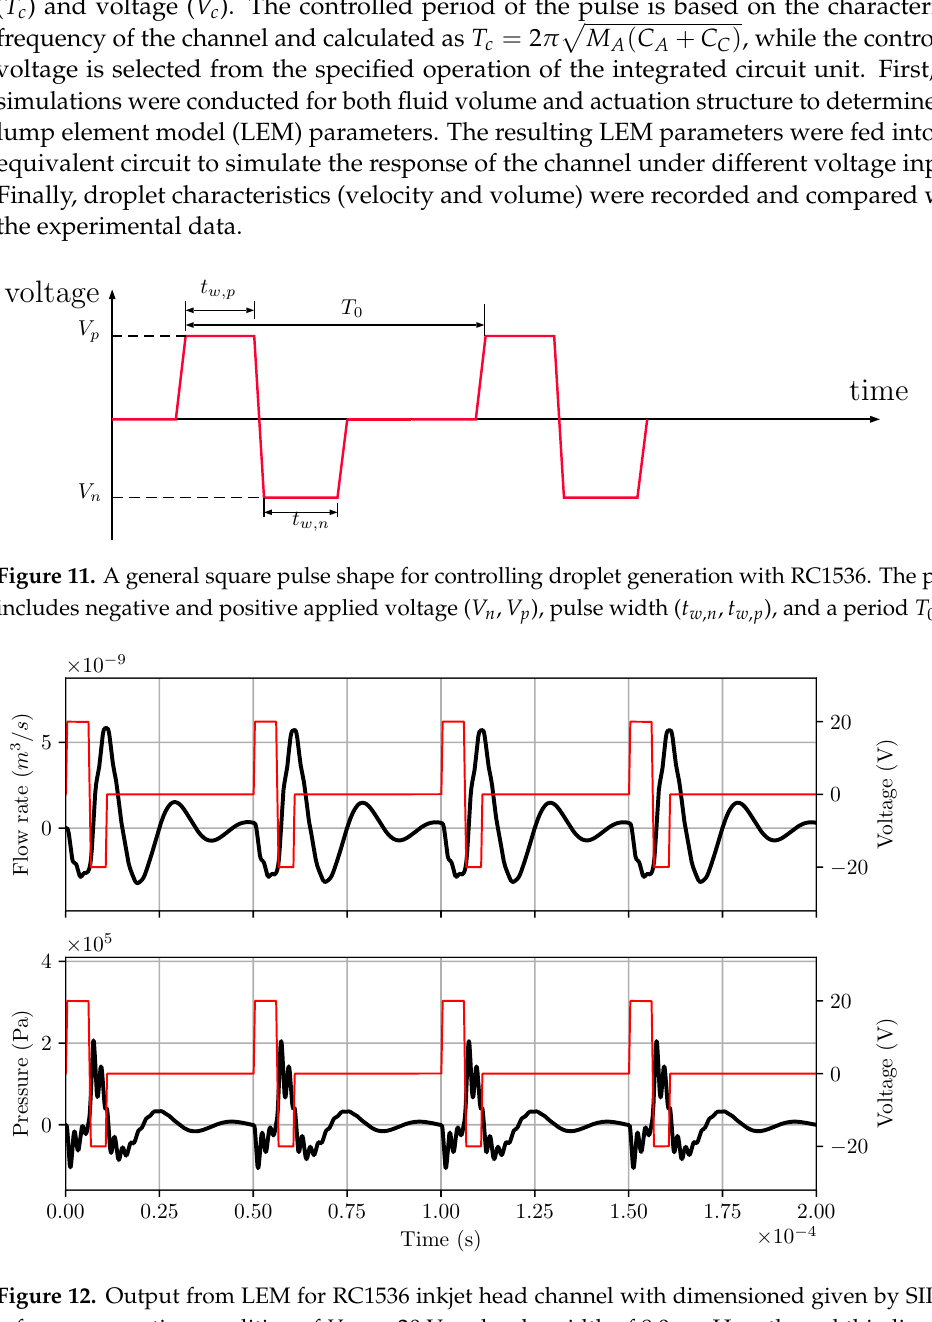
Figure 12. Output from LEM for RC1536 inkjet head channel with dimensioned given by SII at a reference operating condition of V ref = 20 V and pulsewidth of 8.0 µ s. Here the red thin lines are voltage signal applied at the actuator and black thick lines are flowrate and pressure